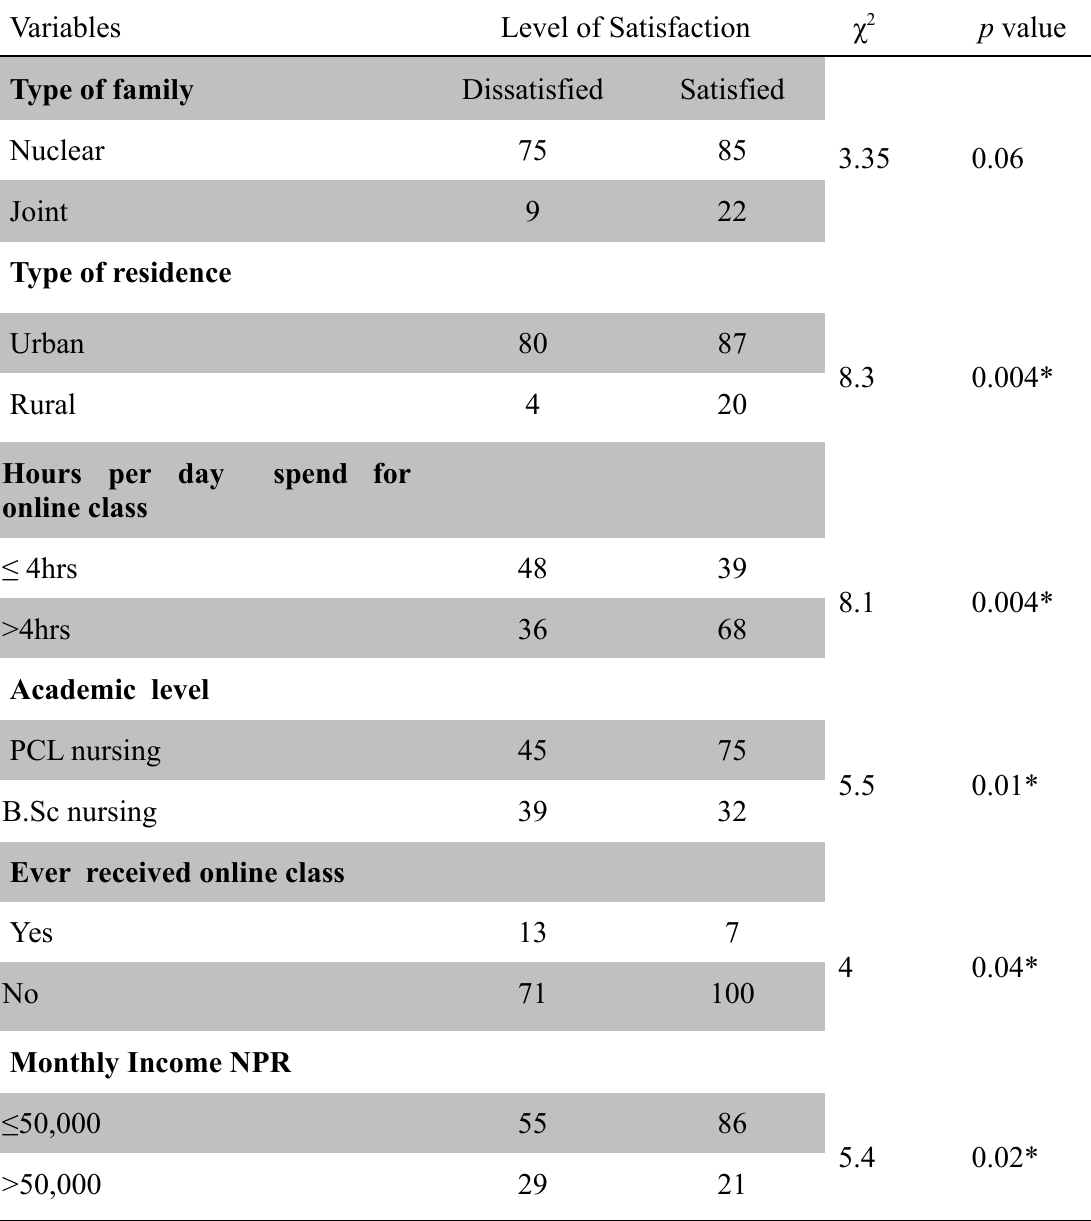
Table 4: Association between Levels of Satisfaction with Selected Variables (n=191)